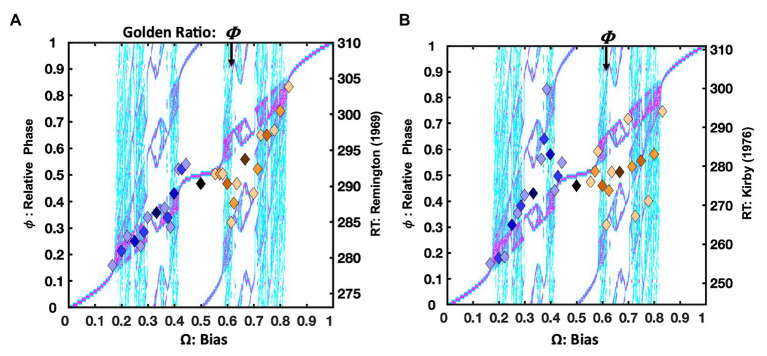
For continuity, plot (A) again depicts the Remington’s (1969) data as color-coded diamond markers, depicting the 31 ratios, just as in Figure 2B, now atop a detailed bifurcation diagram portraying the potential range of the relative phase relations (ϕ) that arise in the model’s dynamics. Rather than the whole-orbit counts of p/q, relative phase (ϕ) relates two oscillators as an angular difference in their respective cycles. Regions in white indicate the absence of a phase attractive region, turquoise shades (lighter gray) indicate relatively weaker phase attractive regions, and pink shades (darker gray) indicate stronger phase attractive regions. The bifurcation diagram illustrates how the attractors encoded by the staircase can be achieved through a variety of relative phase relations. The Devil’s staircase is an asymptotic summary of these dynamics, in integer counts of both oscillator’s respective cycles. Plot (B) depicts (Kirby’s, 1976) delayed ITI version of a two-button task. The raw data was unavailable. It was estimated from measurements of an enlarged photograph of a plot in the original published article and transformed to the millisecond scale, based on the graph’s axes. The correlation between the normalized latencies and their predicted Farey ratios is weaker than Remington’s data, r(29) = 0.52, p < 0.003. While the markers deviate more from the staircase than the Remington data set, the bifurcation diagram indicates the deviations are generally consistent with the model’s phase attractive topology, as indicated in the bifurcation diagram. Both right-hand Y-axes in this and all subsequent response time plots depict the trial-histories’ untransformed latencies in milliseconds (ms).